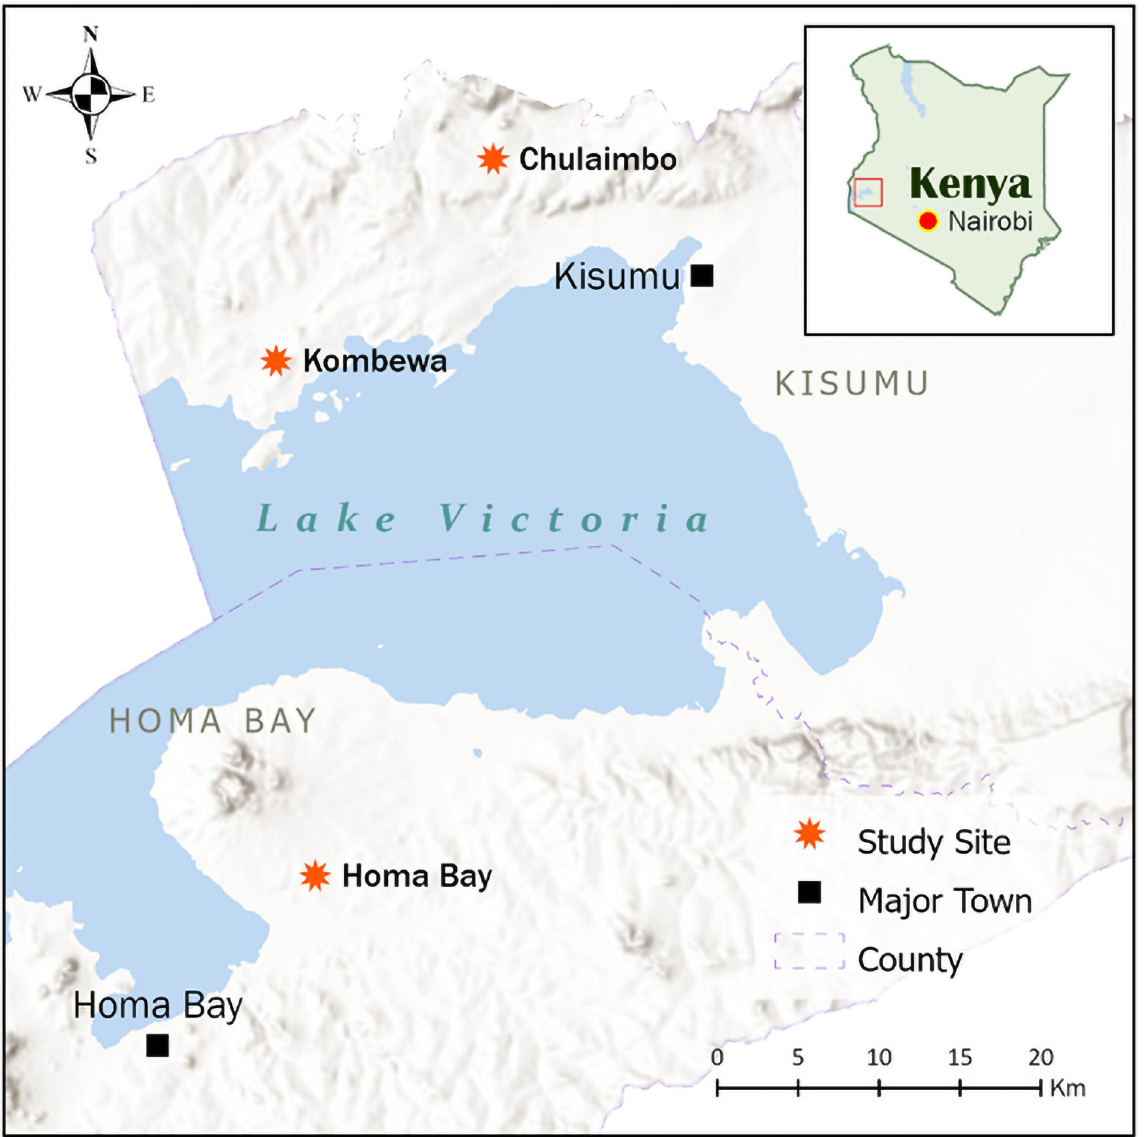
Fig 1. Map of Western Kenya showing the sampling locations. The map was generated using ArcGIS Pro 2.6 software. Map source: ESRI, CGIAR, and USGS (available at: www.esri.com).